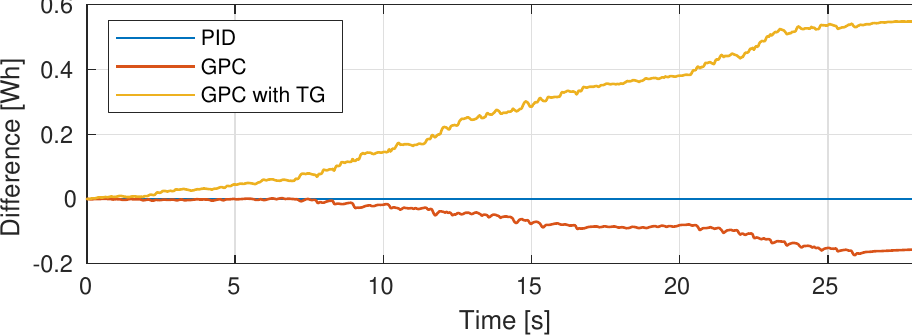
Figure 7. Total energy consumption during the Fixed Trajectory Experiment: MPC compared to PID.